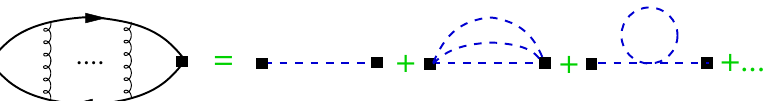
Figure 6. Schematical composition of QCD sum rules for conventional mesons (blue dashed lines) [30].